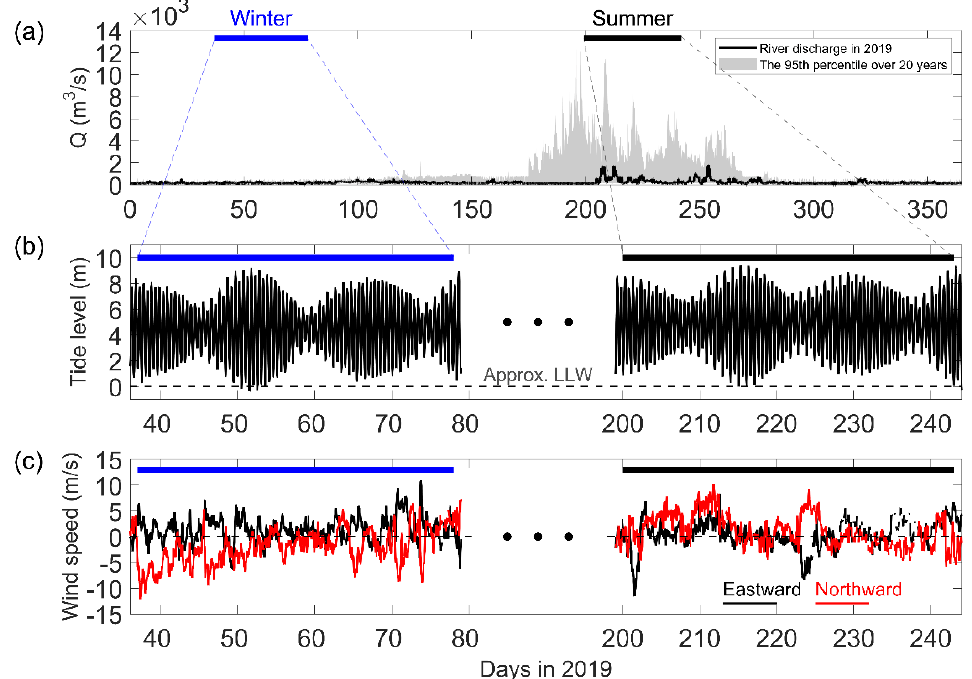
Figure 2. Observed data used in the study. ( a ) Annual River discharges. Two bars (winter and summer) indicate simulation periods of the FVCOM model; ( b ) observed tide at T3; and ( c ) observed wind speed at DJD ocean buoy.